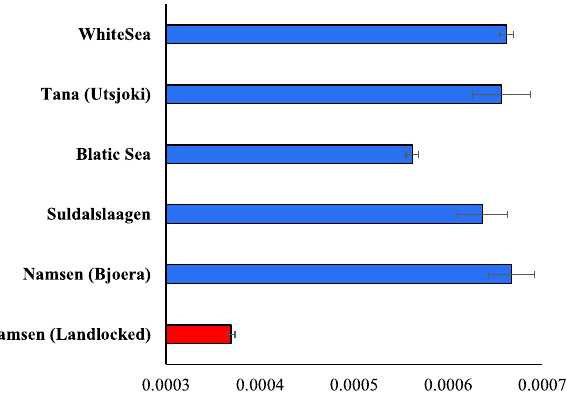
Figure 2. Genomic heterozygosities estimated for five anadromous and one landlocked population of Norway are shown. Error bars denote the standard error of the mean. The genomic diversity of the landlocked salmon population was significantly smaller than those of anadromous populations (at least, P <